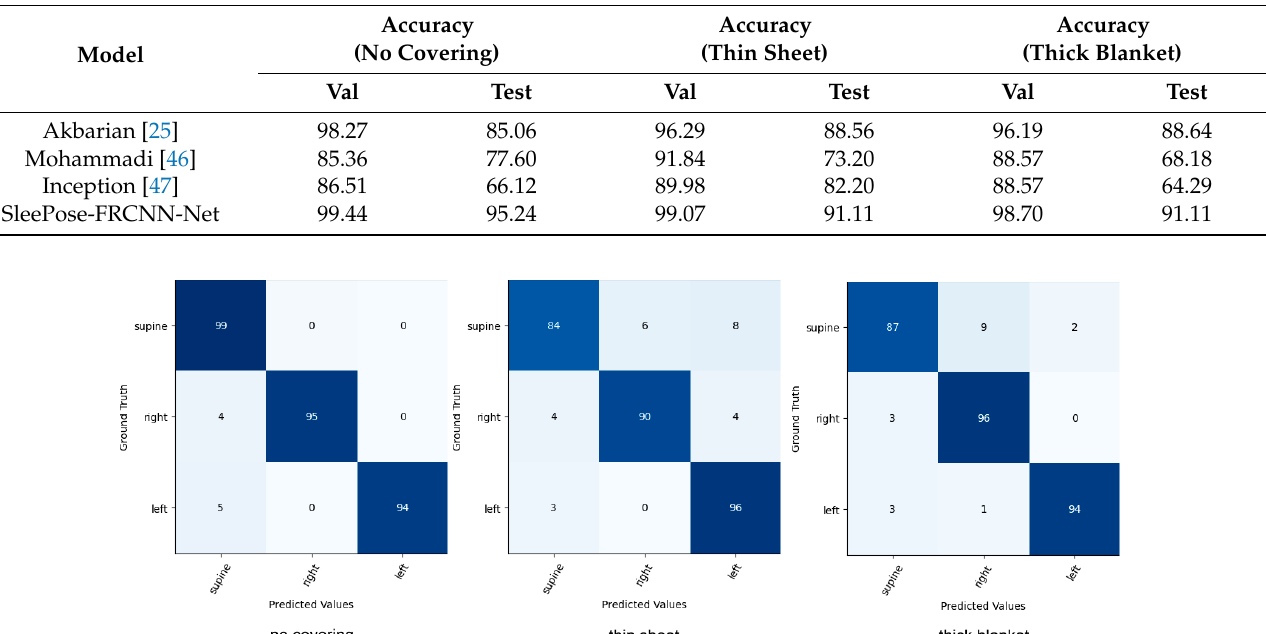
Table 9. Results of upper-body pose classification on the SLP dataset.